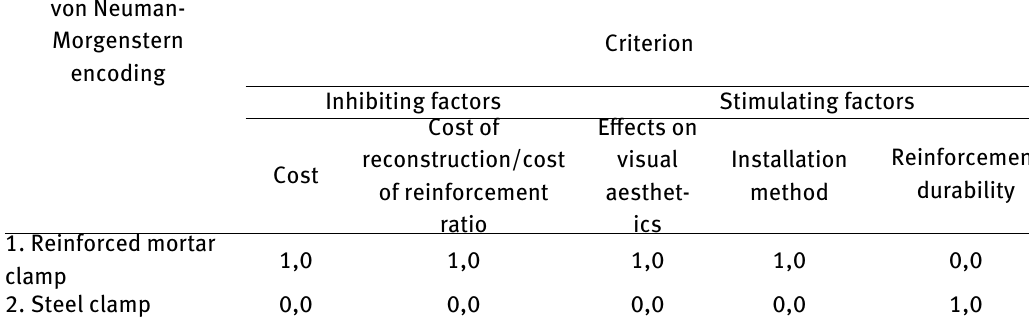
Table 9: Values calculated with the von Neumann – Morgenstern encoding method (own studies) von Neuman-